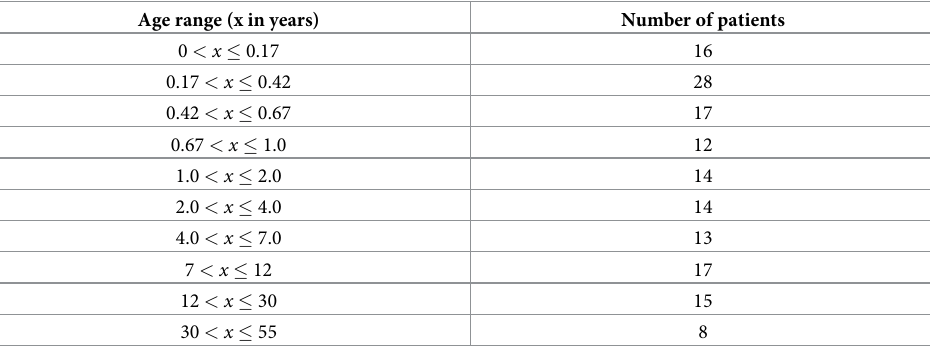
Table 2. Age distribution of the 154 individuals included in the